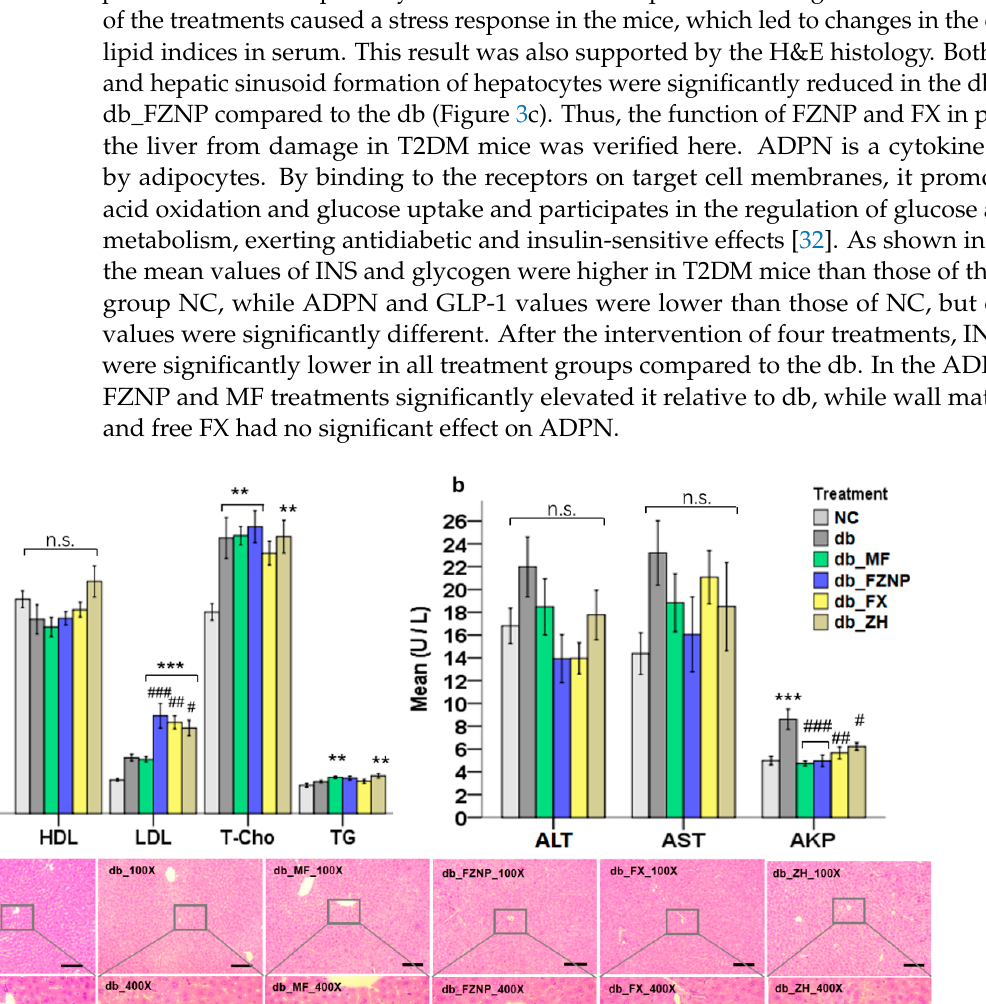
Figure 4. Indicators of blood, insulin and glucose metabolism in serum as well as liver tissue and gene expression measured by qPCR. The levels of INS/ADPN ( a ), GLP-1/Glycogen ( b ), glutathione peroxidase (GSH-Px) activity, superoxide dismutase (SOD) activity and catalase (CAT) activity ( c ), non-esterified free fatty acids (NEFA) and malondialdehyde (MDA) ( d ), HOMA-IR ( e ), and